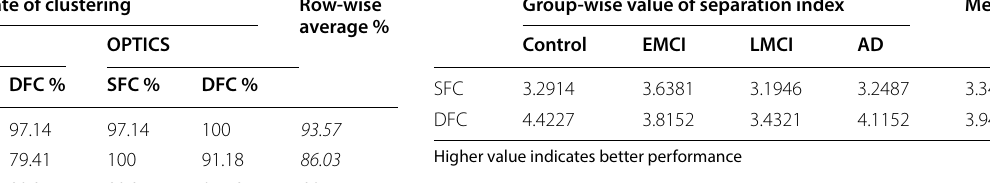
Table 2 Success rate of clustering for each group and each feature, for both DBSCAN and OPTICS Success rate of clustering